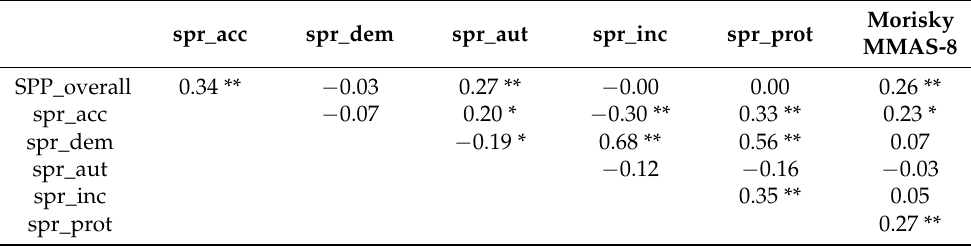
Table 2. Pearson’s correlations between the overall resilience score, parental attitudes and the regularity of taking